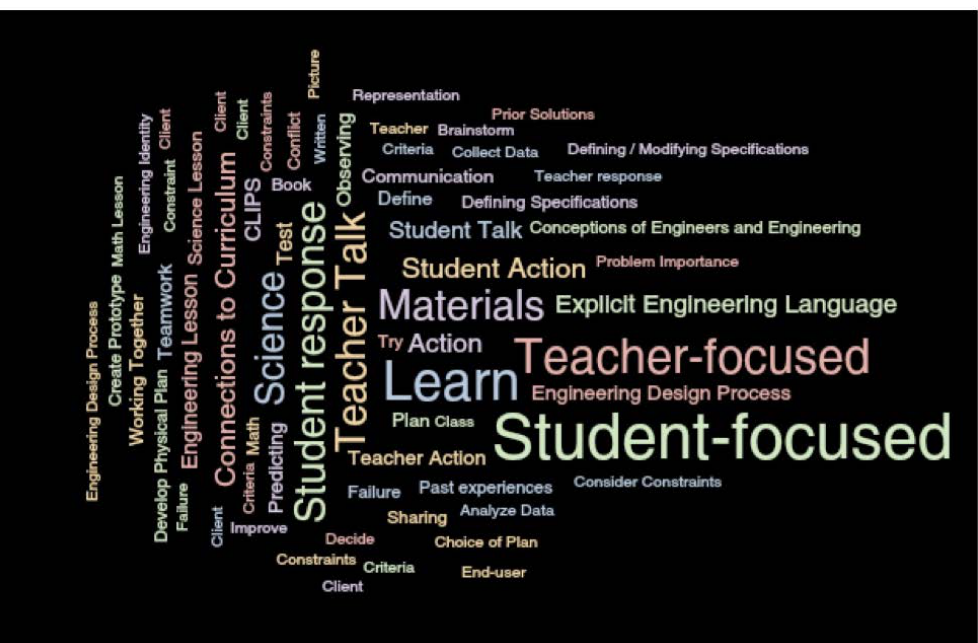
Figure 2. Word cloud indicating number of times each code was used in relation to all